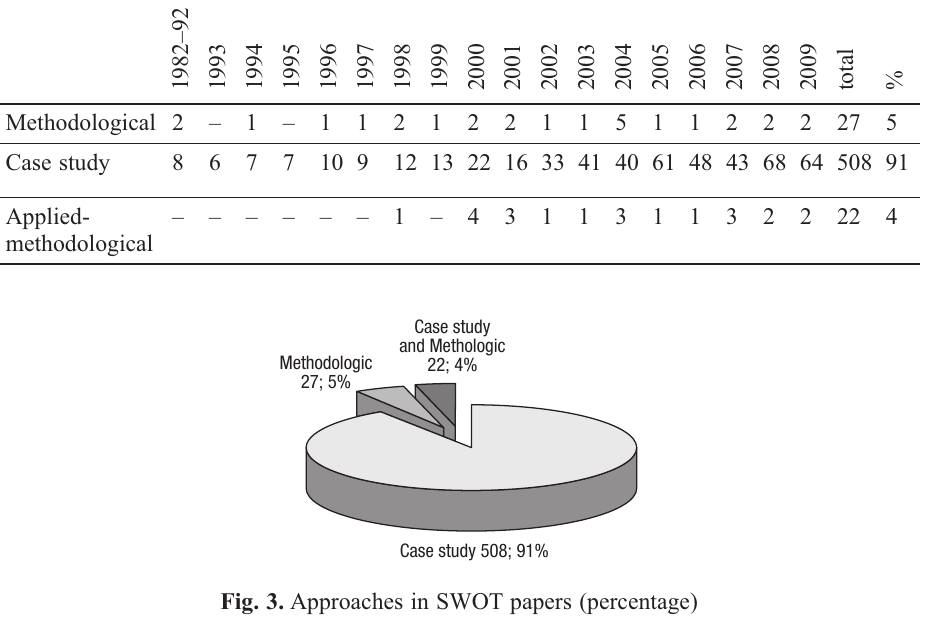
Table 6. Approaches in SWOT papers in each year